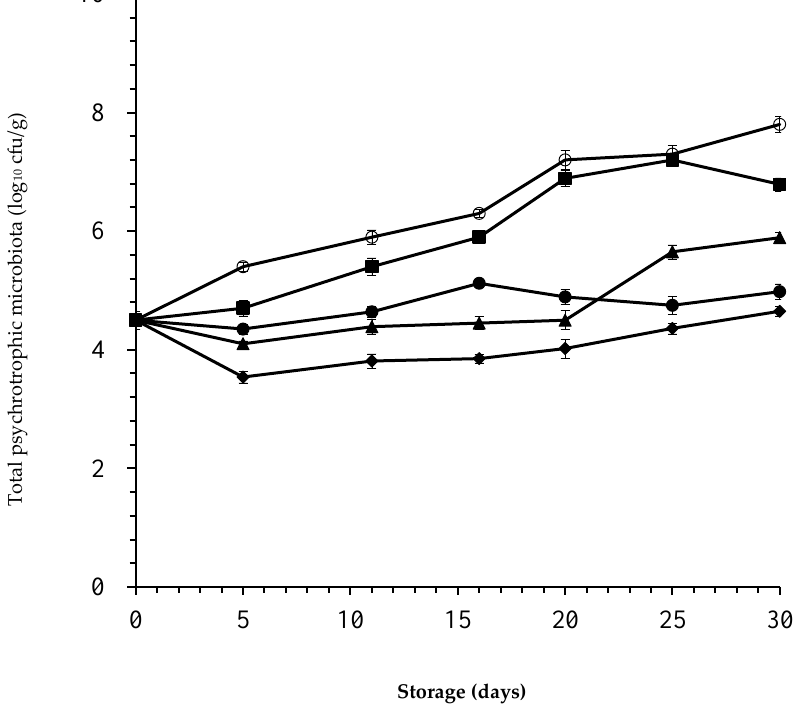
Figure 4. Numbers (log 10 cfu/g) of total psychrotrophic microbiota (TPM) recovered from camel steaks stored at 1 ± 1 ◦ C under atmospheres of 80% O 2 and 20% CO 2 after treatment with 25 ppm nisin ( (cid:4) ); 500 ppm laper .OLE ( (cid:78) ); 25 ppm nisin / 500 ppm laper .OLE ( • ); 25 ppm nisin / 1000 ppm laper .OLE ( (cid:117) ); or untreated samples ( ). Error bars represent the standard deviation.